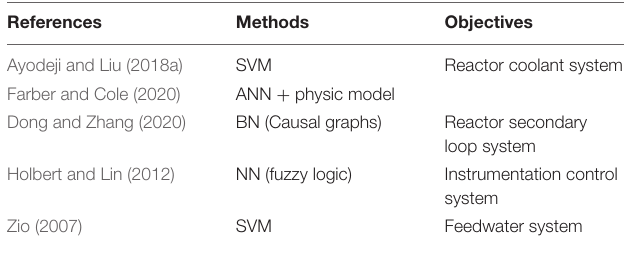
TABLE 4 | Latest applications of the data-driven machine learning (DDML) for the fault diagnosis and detection (FDD) of the nuclear power plant (NPP)